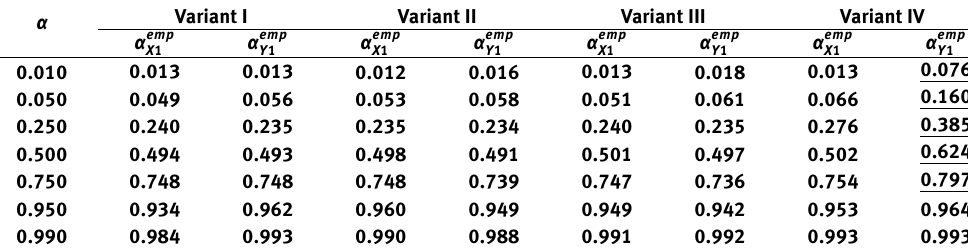
Table 5. Empirical significance levels α emp